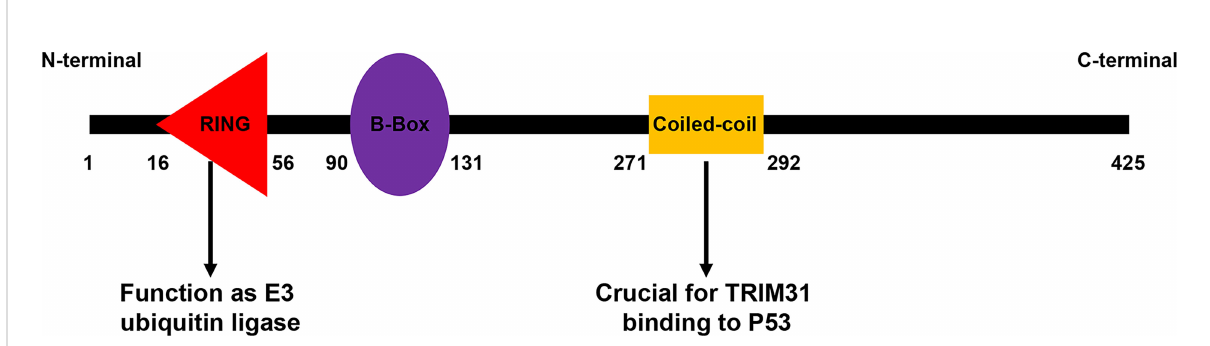
FIGURE 1 Domain organization of the TRIM31 protein. The different TRIM31 domains are reported with numbers and indicate the fi rst and last amino acids of each